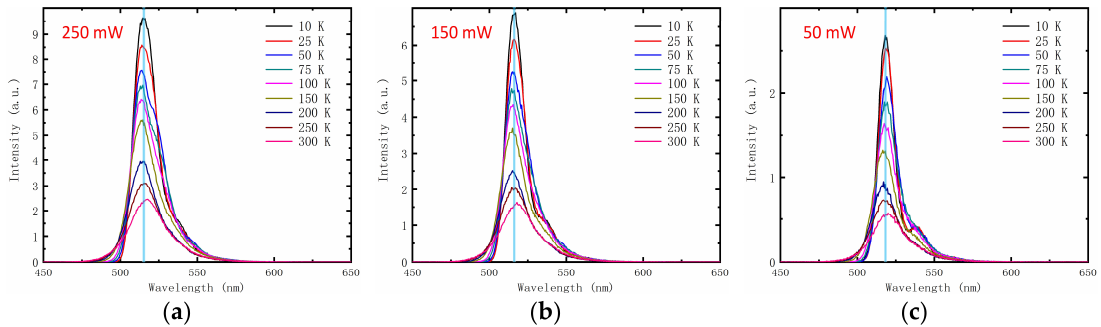
Figure 2. The spectra at different temperature and excitation power of ( a ) 250 mW, ( b ) 150 mW and ( c ) 50 mW. The blue lines designating central wavelengths (CWs) at low temperature (LT) are shown to observe the shift clearly.